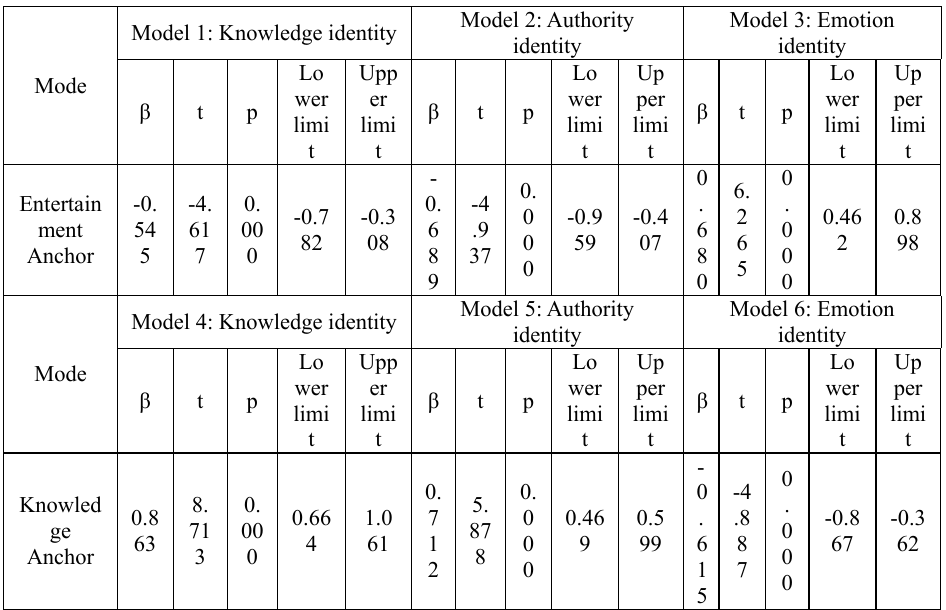
Table 3. Effects of live broadcast marketing mode on user